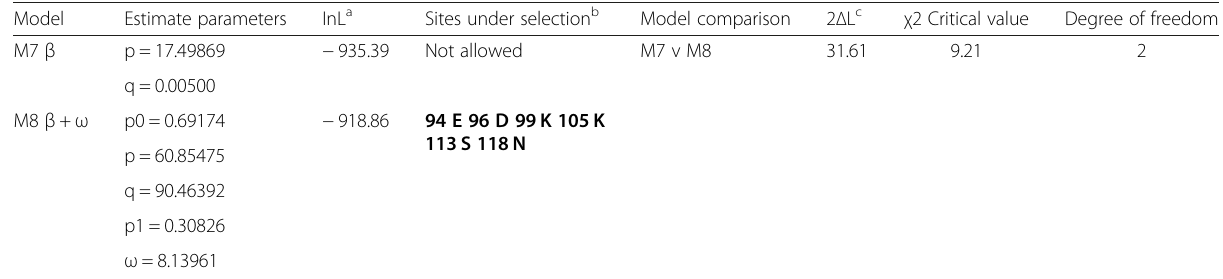
Table 1 Likelihood ratio test results for Avr1c